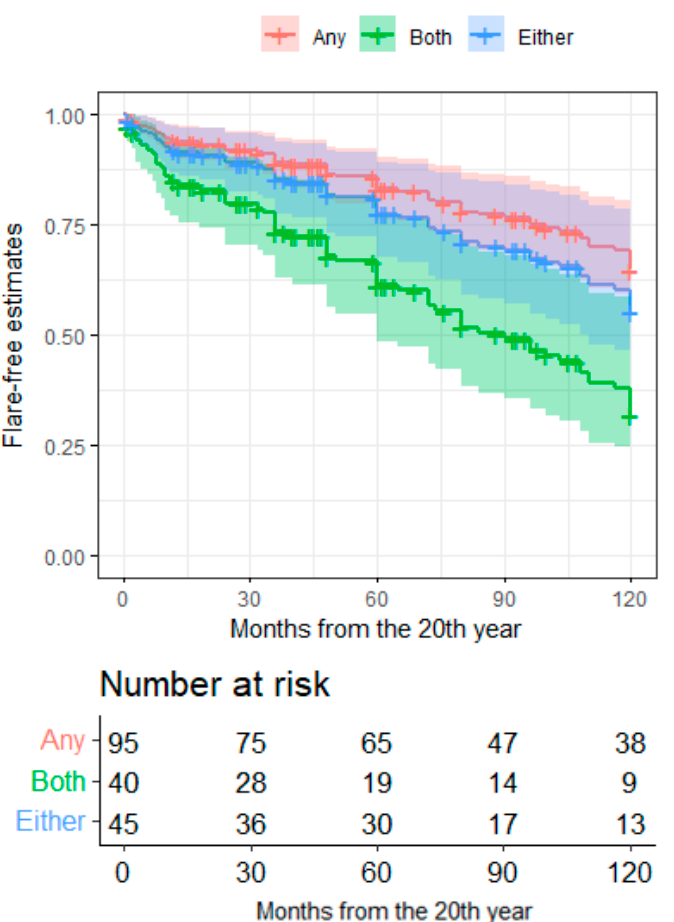
Figure 3. Ten-year flare-free estimates in long-term SLE patients according to serology at 20th years. Flare-free survival estimates after the 20th year of disease according to the serological status at the 20th year. Both—presence of both serological alterations (low dsDNA AND hypocomplementemia); Either—presence of either serological alterations (low dsDNA OR hypocomplementemia); Any— absence of any serological alteration.